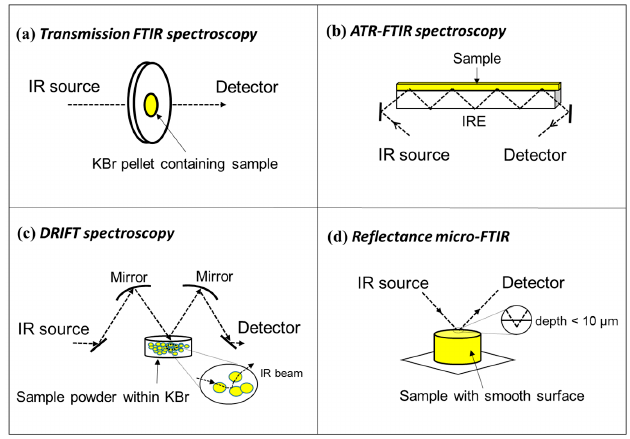
Figure 1. Simplified schematics of common Fourier transform infrared spectroscopy (FTIR) analysis modes including: ( a ) transmission FTIR; ( b ) attenuated total reflectance (ATR)-FTIR. Note that the penetration depth is dependent on the physical characteristics of internal reflection element (IRE) material and the angle of incidence [7]; ( c ) diffuse reflectance infrared Fourier transform (DRIFT) spectroscopy; ( d ) reflectance micro-FTIR. The penetration depth for reflectance micro-FTIR is usually less than 10 μ m. Modified after figure 1 in Parikh and Chorover [8] with copyright permission from Taylor & Francis.